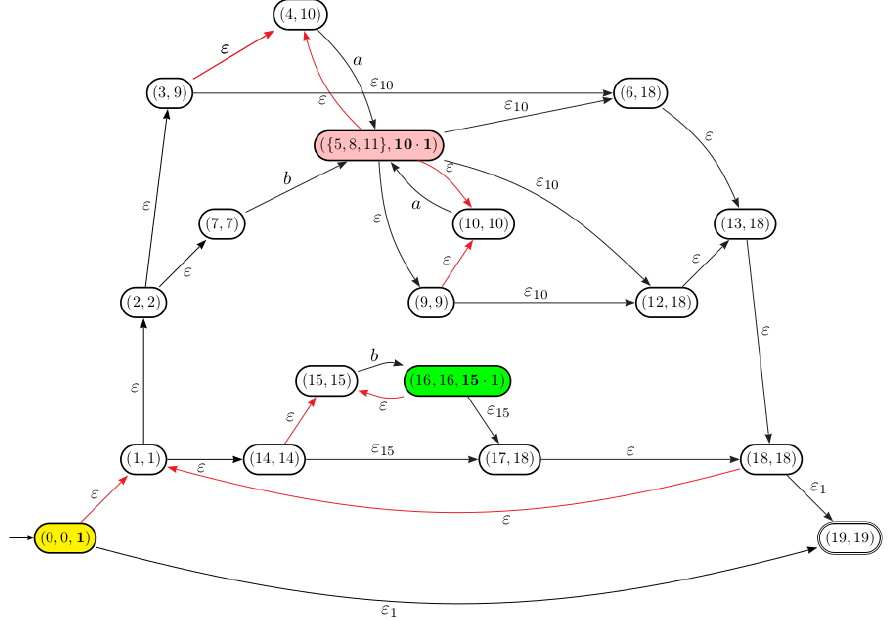
( Id ( T )) associated with E = ( a ∗ + ba ∗ + b ∗ ) ∗ E e